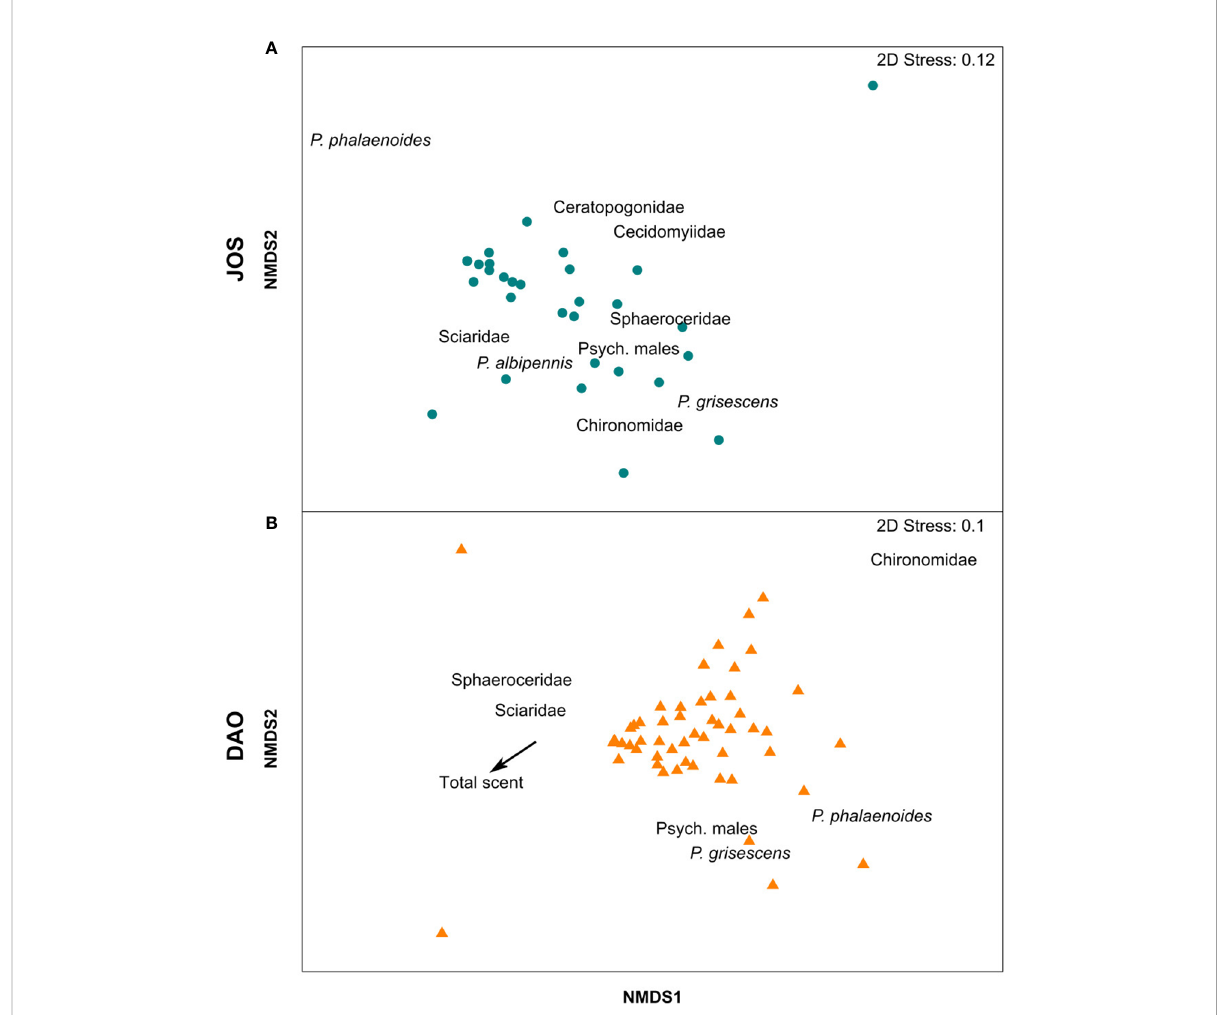
FIGURE 3 Non-metric multidimensional scaling (NMDS) plots based on Bray – Curtis dissimilarities of relative abundances of insect groups in the two studied populations of Arum maculatum : (A) JOS (blue dots, N = 31) and (B) DAO (orange triangles, N = 57). Insect groups that correlated most with the axes are displayed (Spearman ’ s correlation coef fi cient > |0.2|). In (B) the arrow indicates the vector of total scent, which predicted visitor composition in DAO based on DistLM analysis (see text for details). P. , Psychoda ; Psych.,